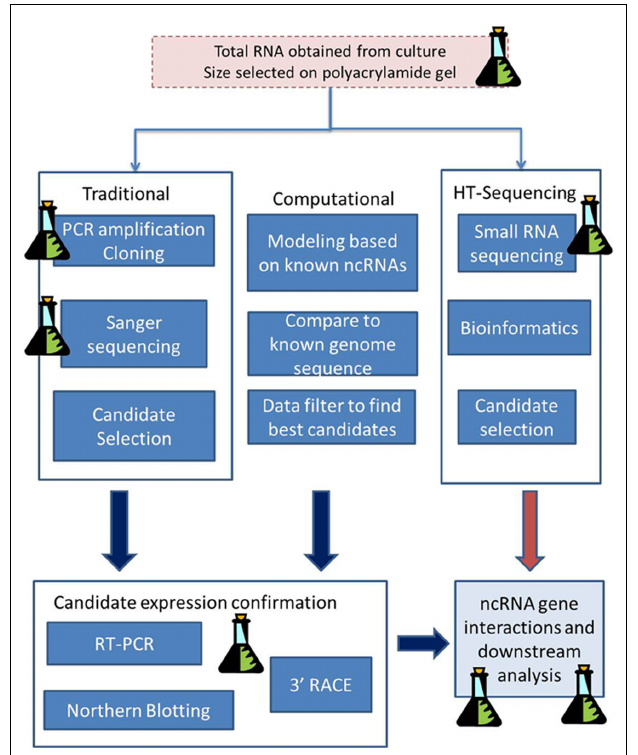
FIGURE 1 | Genomic approaches to ncRNA identification. Both the traditional laboratory approach and the more recent high-throughput sequencing approach begin with the isolation of total RNA from culture, followed by size selection of the RNA by excising a given band from a polyacrylamide gel. Under the traditional approach the excised RNA is cloned then sequenced by Sanger Sequencing to obtain candidate miRNA sequences.With High-throughput sequencing the RNA is sequenced directly without cloning and bioinformatics is used to select the best candidates. Computational approaches do not begin with biological samples but instead use mathematical models based on known ncRNAs to search an already sequenced genome. Both the traditional and computational approaches require that candidate gene expression be confirmed by additional laboratory work. Key: Molecular biology stages are represented by the flask icon. All other stages use RNA genomic and bioinformatics